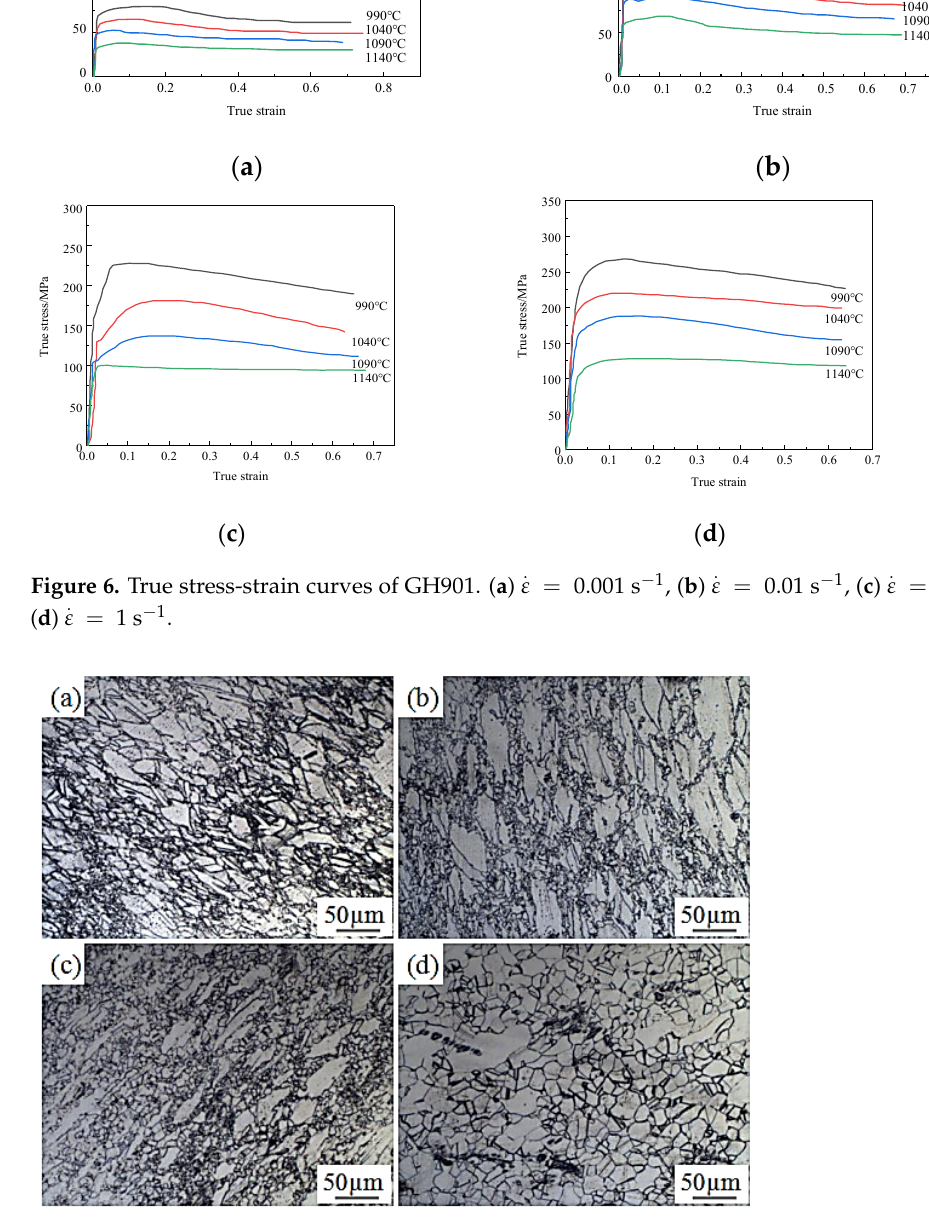
Figure 7. Microstructure of GH901 superalloy deformed at 1 s − 1 . ( a ) Microstructure at 990 ◦ C,